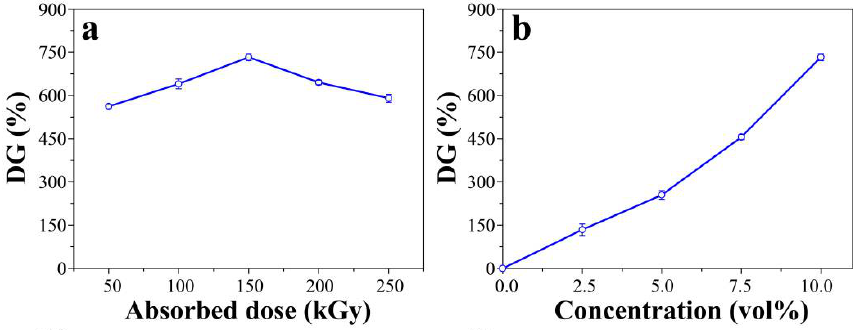
Figure 1. DG of UHMWPE fibers as a function of ( a ) absorbed dose (10 vol%, 65 °C, 2 h), ( b ) GMA concentration (150 kGy, 65 °C, 2 h), ( c ) reaction temperature (150 kGy, 10 vol%, 2 h), and ( d ) reaction time (150 kGy, 10vol%, 65 °C). 2.2. Characterization of Modified UHMWPE Fibers Figure 2 portrays the attenuated total reflectance Fourier transform infrared (ATR-FTIR) spectroscopy of UHMWPE fibers. The original UHMWPE fiber has reflection bands at 2909, 2843, 1468, and 715 cm −1 , which are due to the asymmetrical stretching, symmetrical stretching, bending, and rocking vibrations of methylene (CH 2 ), respectively. After grafting (trace b), the stretching vibrations of CH 3 at 2918 cm −1 , C=O at 1720 cm −1 , and C–O (ring) at 905 cm −1 confirm the successful grafting of GMA onto UHMWPE fiber [28]. After phosphation (trace c), the absorption peak of C–O (ring) disappears, and fresh peaks of OH and P=O originate at 3100–3500 and at 930–1025 cm −1 , respectively, demonstrating the successful introduction of the phosphate group onto UHMWPE fiber [29]. Figure 2. ATR-FTIR spectroscopy of ( a ) original UHMWPE, ( b ) UHMWPE-g-PGMA (DG = 540%), and ( c ) UHMWPE-PO 4 (D PO = 1.93 mmol∙g −1 ) fibers.